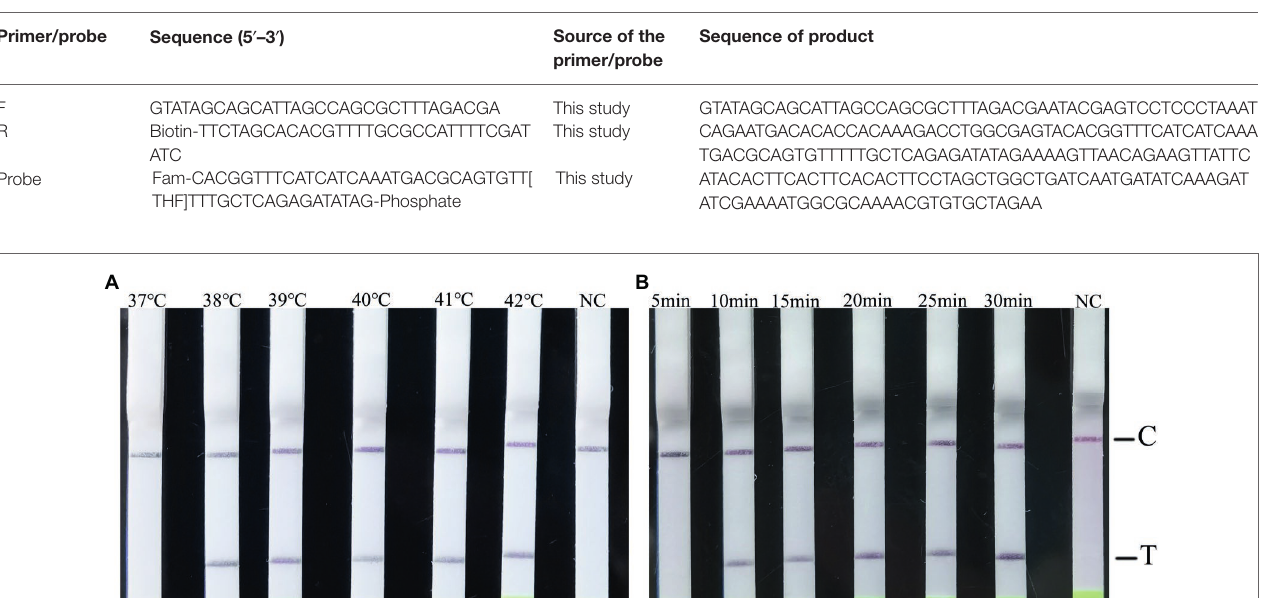
TABLE 1 | Sequences of the primers and probes used for the RAA amplification.